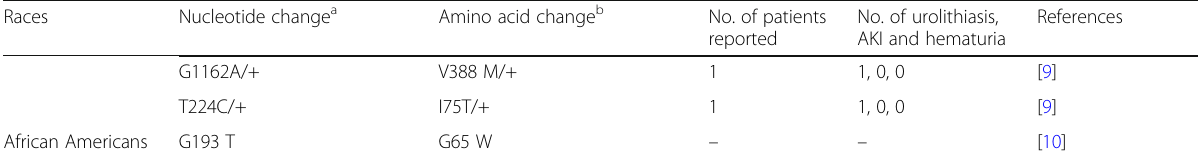
Table 4 Summary of all SLC22A12 gene mutations and clinical data for RHUC patients in varied races (mainly from case reports) (Continued)